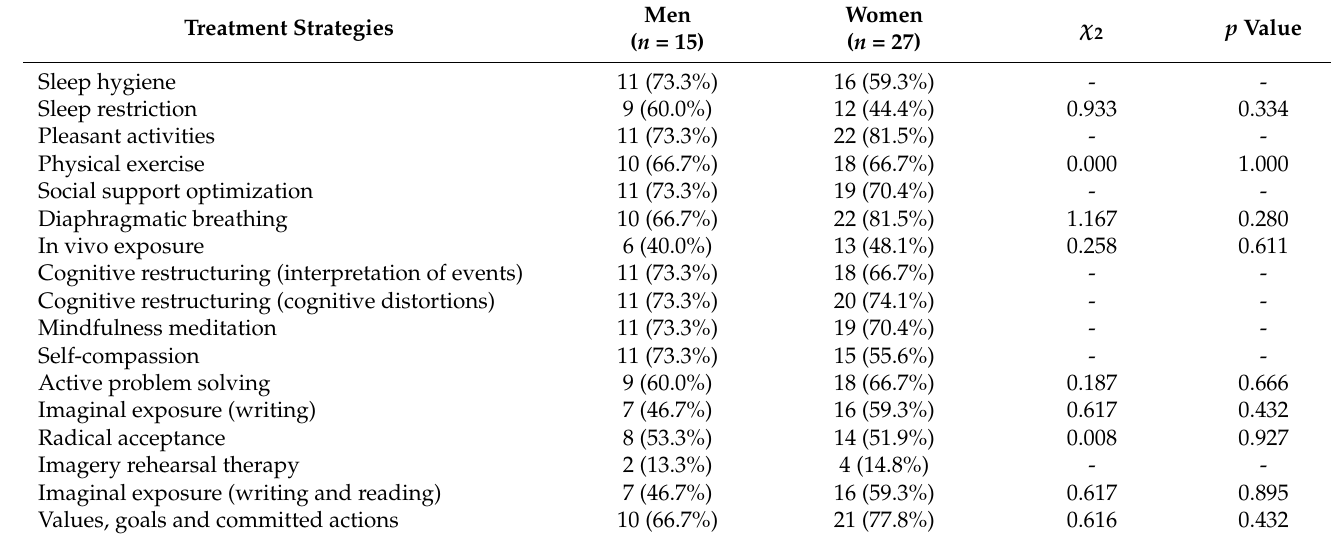
Table 4. Subjective appreciation of treatment strategies by gender: perception of usefulness.